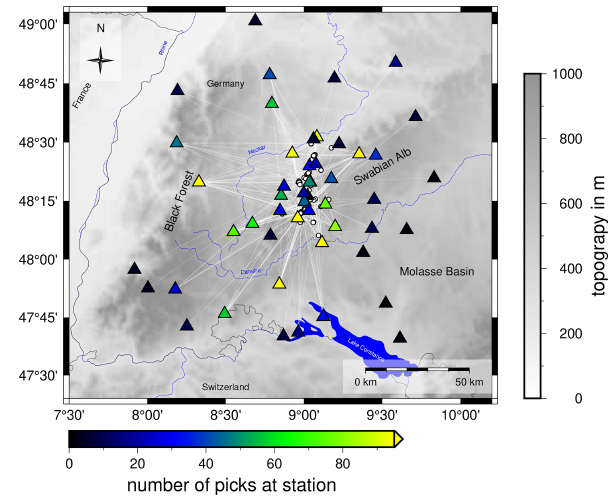
Figure 2. Ray coverage and input data set for the inversion with VELEST. White circles represent the 99 selected events that are used for v p and v s inversion. Seismic stations are indicated as tri- angles and color-coded with the number of high-quality picks at a station used for the v p and v s inversion. Topography is based on the ETOPO1 Global Relief Model (Amante and Eakins, 2009; NOAA National Geophysical Data Center,